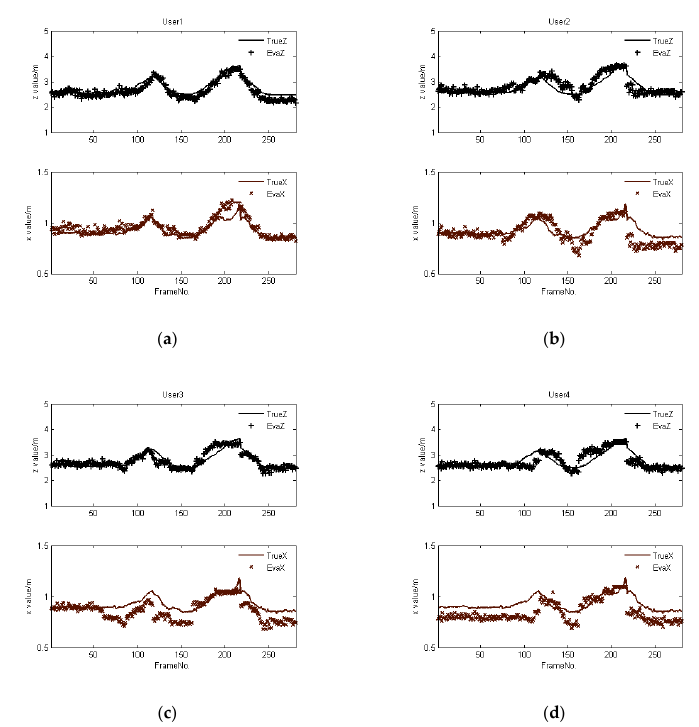
Figure 14. Comparison between trajectories as tracked by a person’s skeleton as opposed to computed using shadows for Path 3, where Users 1, 2, 3, and 4 are randomly selected human participants, and their tracking results correspond to ( a – d ), respectively.